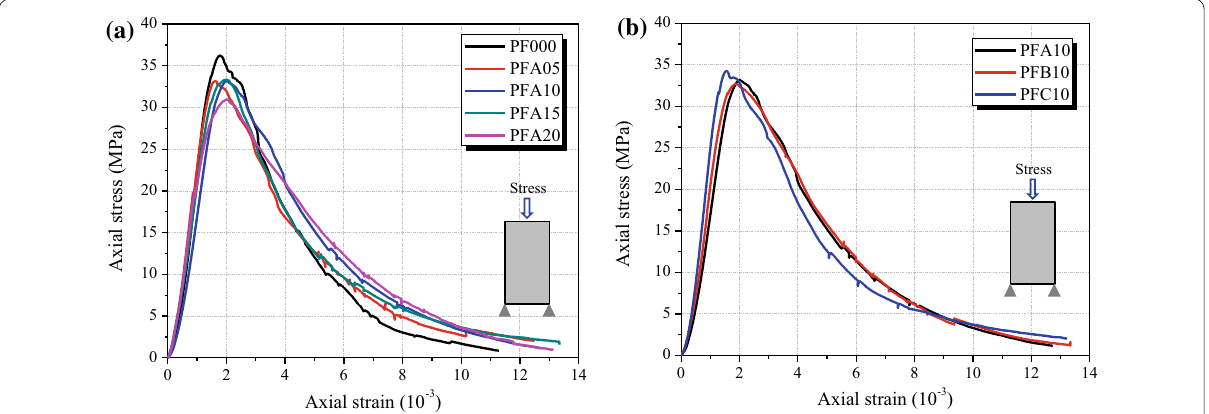
Fig. 4 Monotonic compressive stress–strain curves of PFRC. a Effect of fiber volume fraction. b Effect of fiber aspect